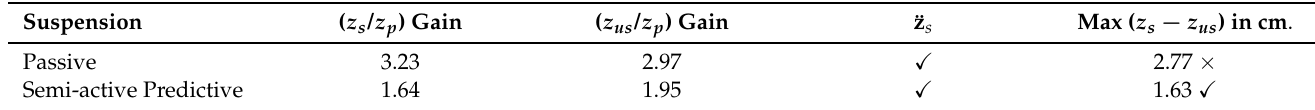
Table 3. Summary of frequency response results.